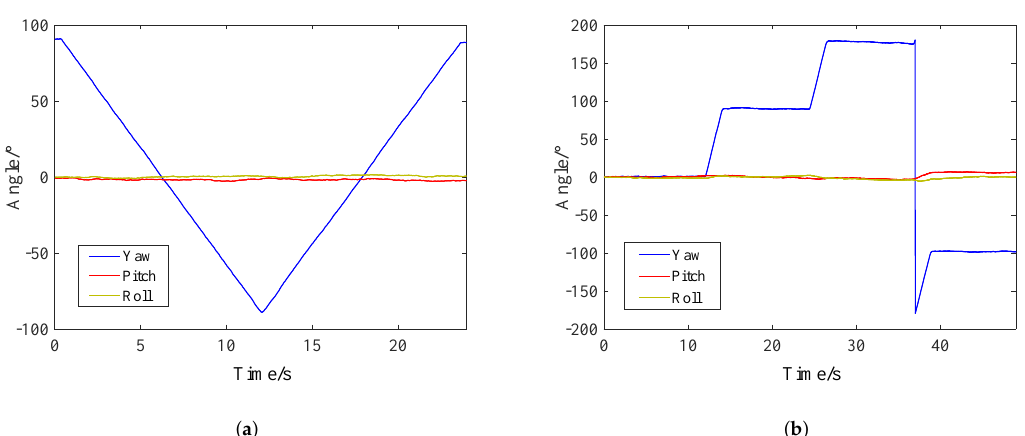
Figure 16. The estimated attitude angles with proposed approach. ( a ) Trajectory A. ( b ) Trajectory